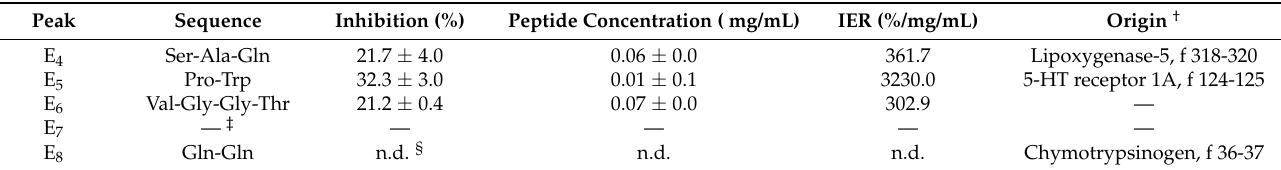
Table 5. Amino acid sequence and inhibition against cholesterol micelle formation of peak E 4 , E 5 , E 6 , and E 8 from fraction E of F-HHP + PN-6 + PP